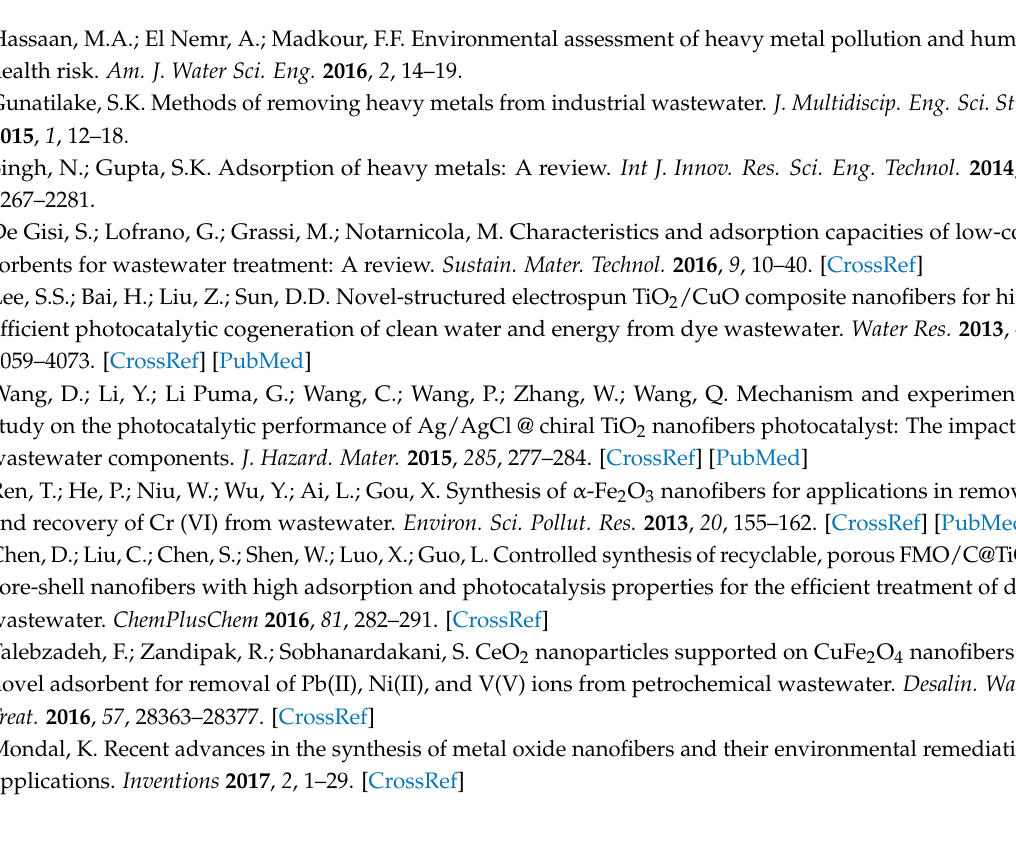
Figure S1: APET cartridge drawing for continuous adsorption experiments; Figure S2: Functionalization degree of PET nanofibers at room temperature; Figure S3: Kaiser test results of blank PET and APET nanofiber mats. Acknowledgments: The financial support for this work was provided by the Innovation Fund for Competitiveness of the Chilean Economic Development Agency (CORFO) under Grant No.